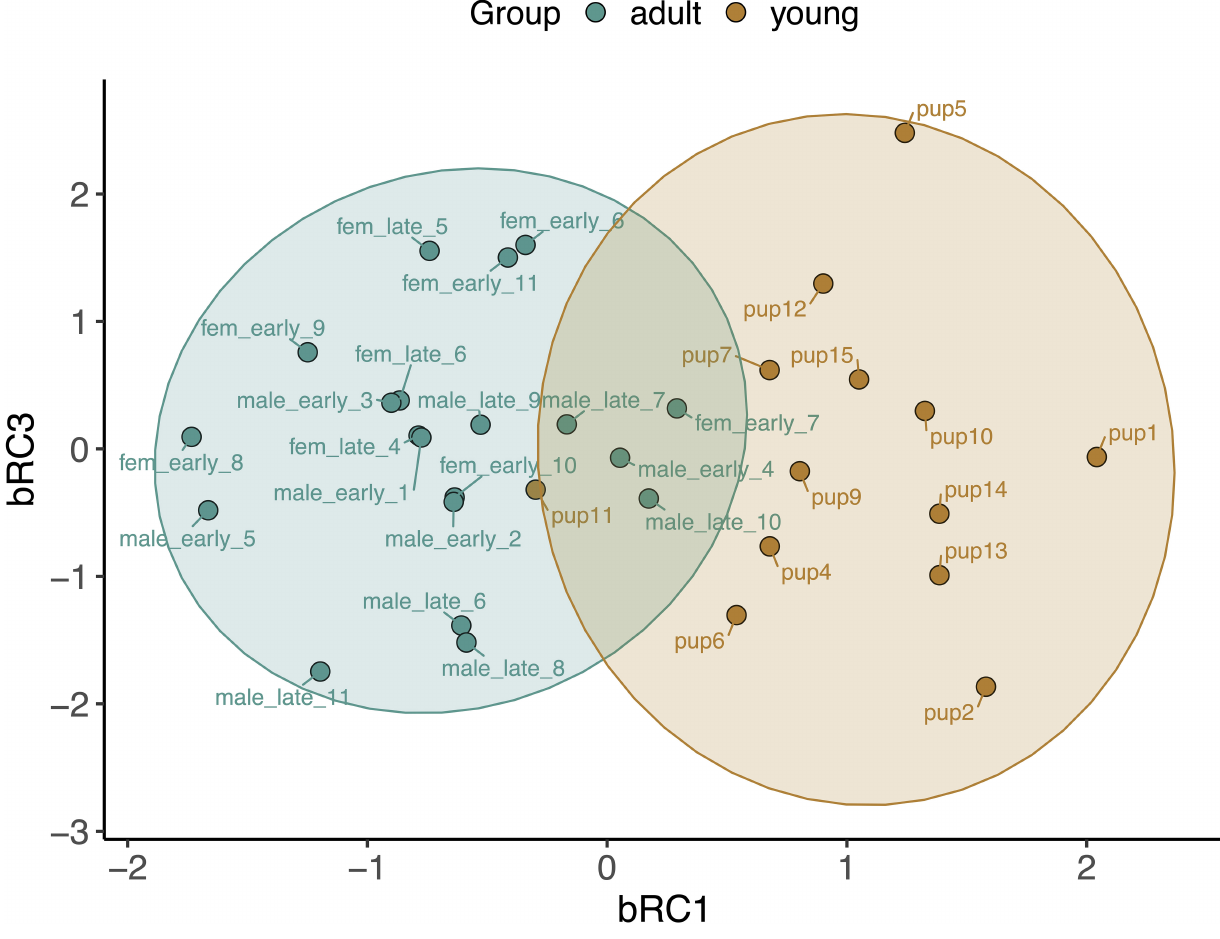
FIGURE 7 | Principal components analysis loading plot for rotated components describing baseline gene expression associated with CO signaling, cytoprotection, and inflammation in whole blood of NES pups ( n = 13) and adults ( n = 20). bRC1: HMOX2 , PRDX1 , TLR4 , CCL4 , TNFA ; bRC3: HMOX1 . Ellipses show 95% confidence intervals for the two age